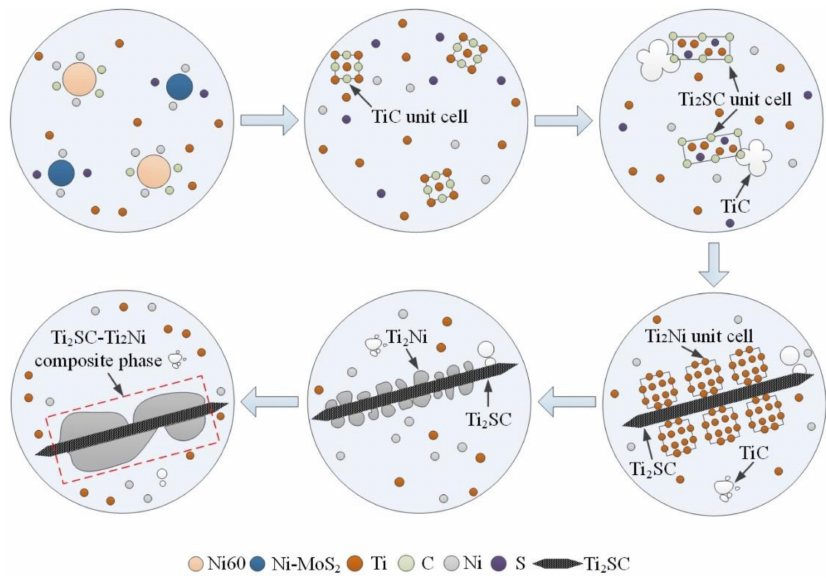
Figure 10. The formation mechanism of the Ti 2 SC-Ti 2 Ni mosaic structure composite phase.